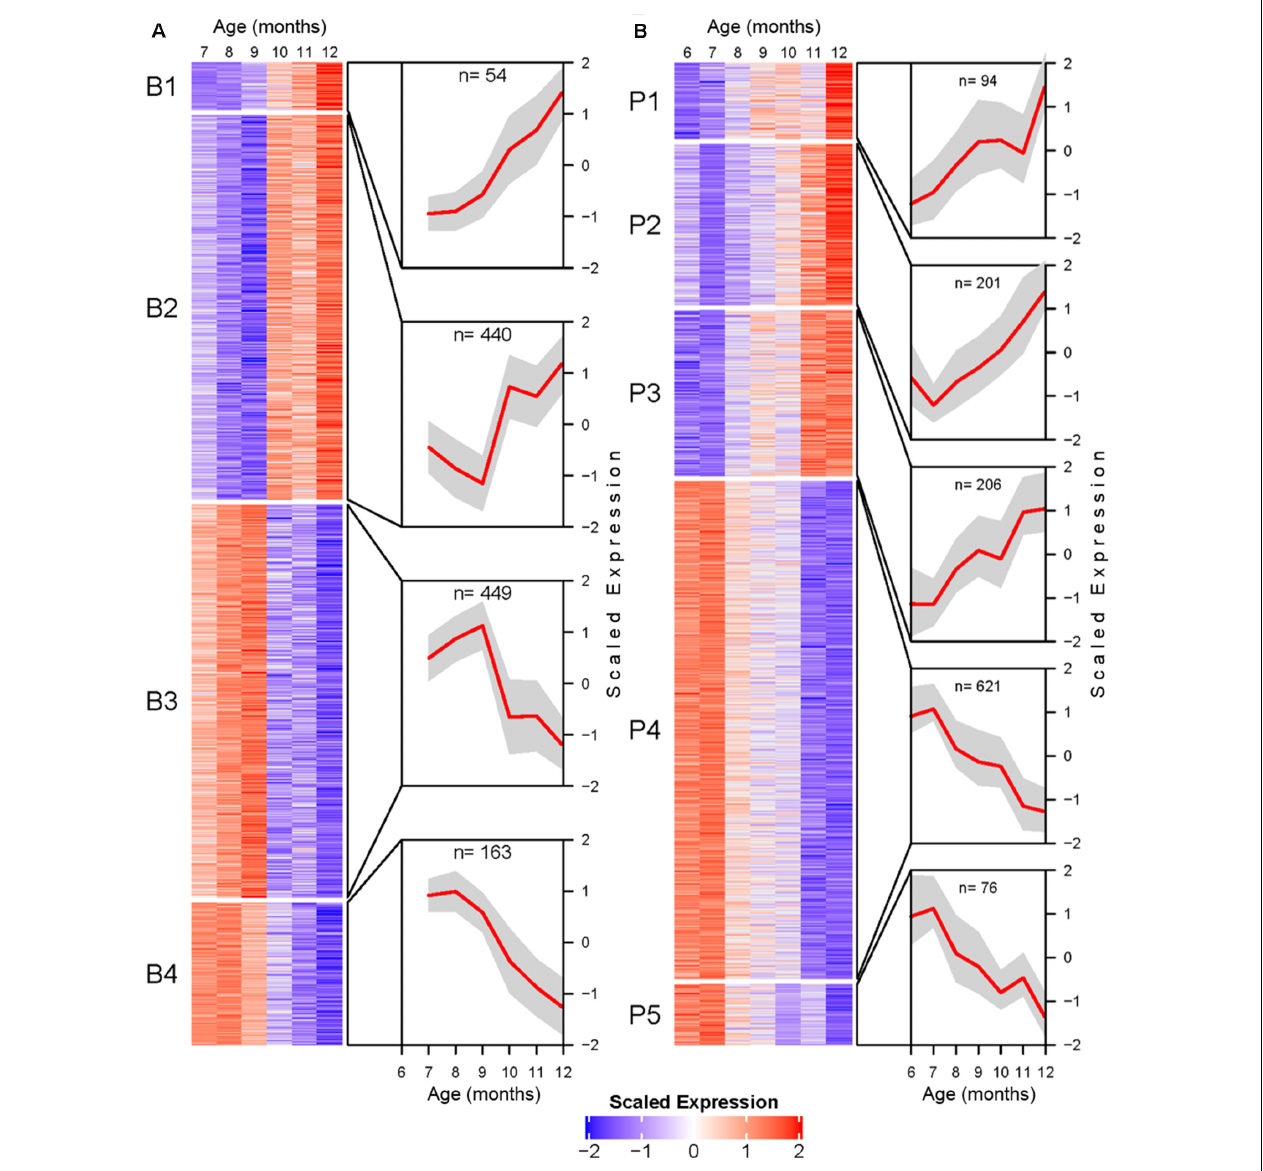
FIGURE 4 | Transcriptional profile cluster heatmaps and trajectories for BSC (A) , and PVC (B) SN. Transcripts determined to be differentially expressed by likelihood ratio test in each tissue were clustered using the DIANA clustering algorithm. Each heatmap corresponds to a cluster. Heatmap cells are mean centered and variance scaled average monthly expression for each transcript (rows) at each month (columns). Cutouts illustrate the cluster average scaled expression ( y -axis) at each month ( x -axis) as a red line with standard deviation as a gray polygon. Total number of genes per cluster are listed at the top of each